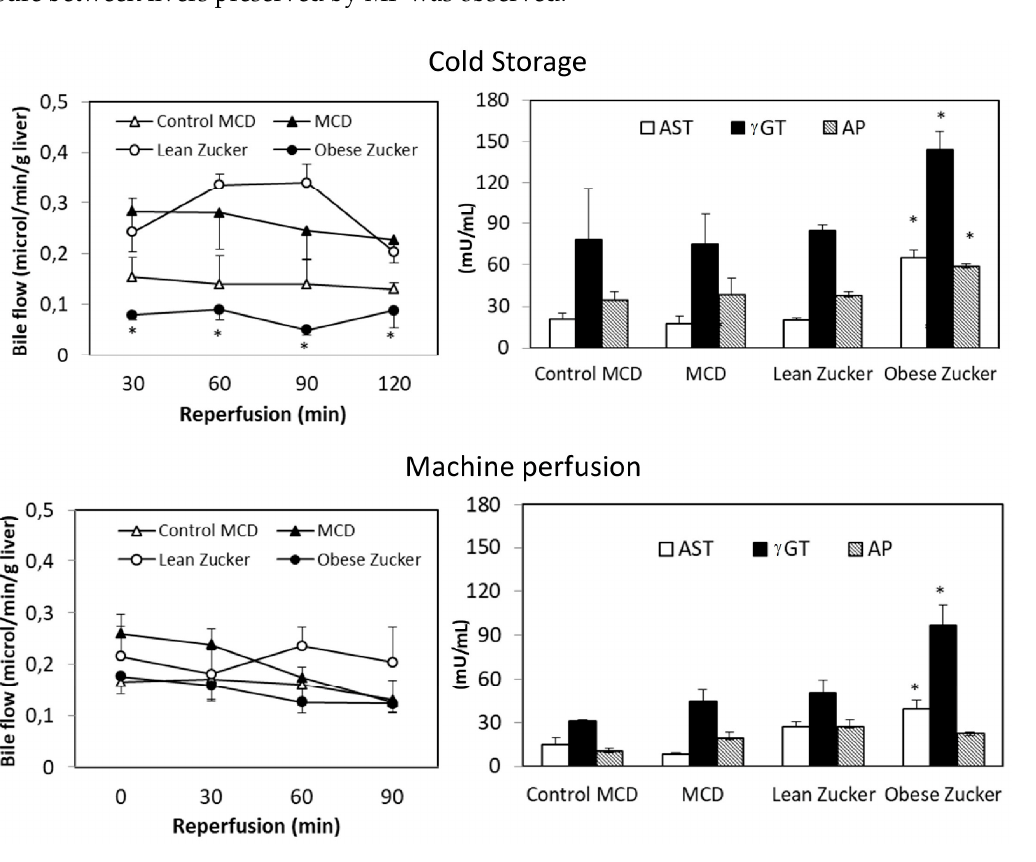
Figure 6. Effects of static CS and dynamic MP on bile flow and biliary enzymes: AST; γ GT; AP at the end of reperfusion in MCD and Zucker rats. The values are reported as means ± SE, n = 7/group. * <0.05 versus MCD.